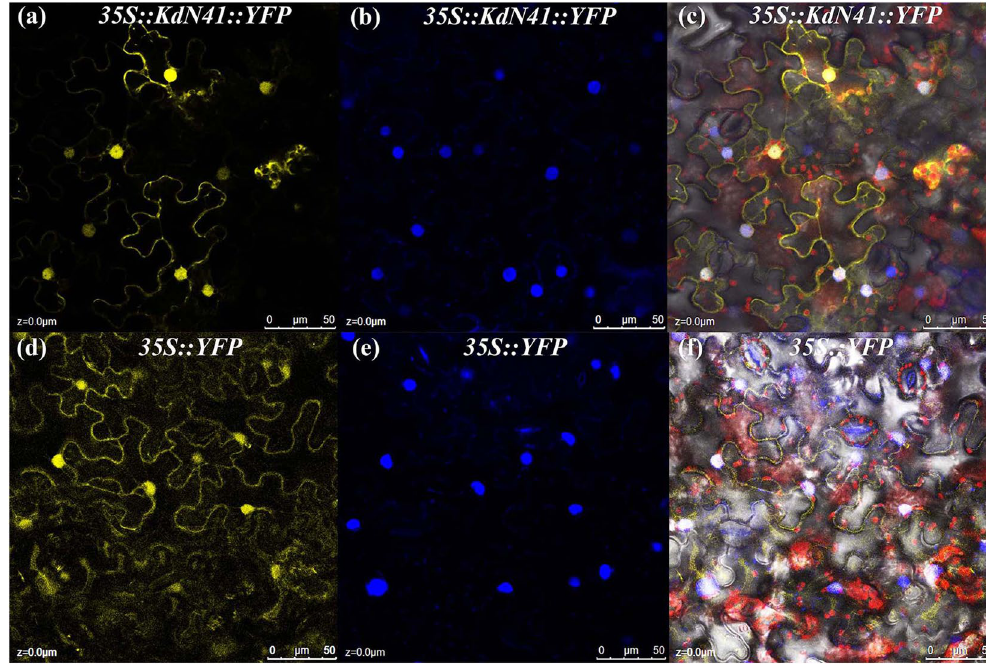
Figure 2. Sub-cellular localization of KdN41 gene in tobacco epidermal cell. ( a , d ) 35 S::N41::YFP and 35 S::YFP signal detection; ( b , e ) DAPI staining signal detection; ( c , f ) merged